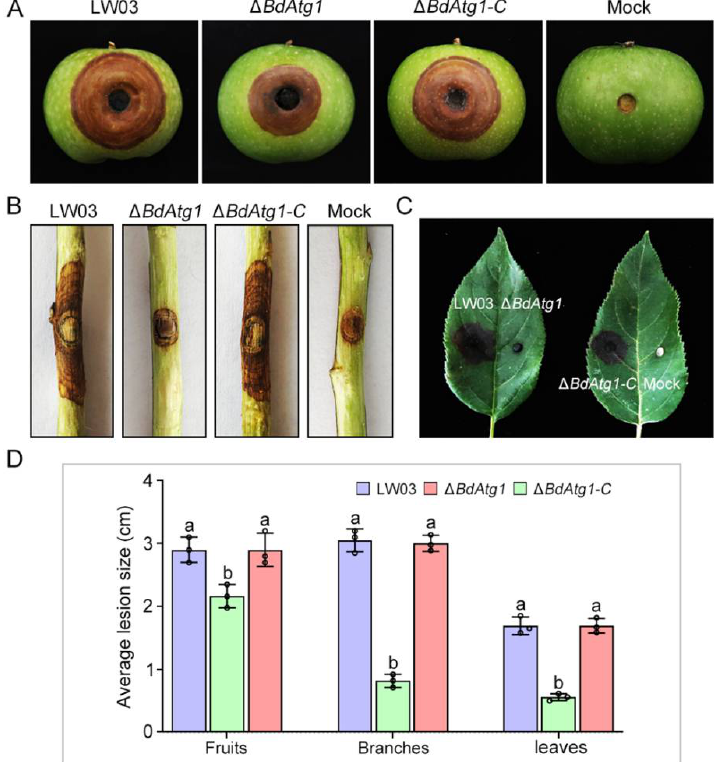
Figure 6. BdAtg1 is required for virulence. Disease symptoms on apple fruits ( A ), branches ( B ) and leaves ( C ) following inoculation with B. dothidea strains for 7 days. ( D ) Lesion size on apple fruits, branches and leaves caused by each strain. Error bars indicate standard deviation from three independent experiments. Values on the bars followed by the same letter are not significantly different at p =